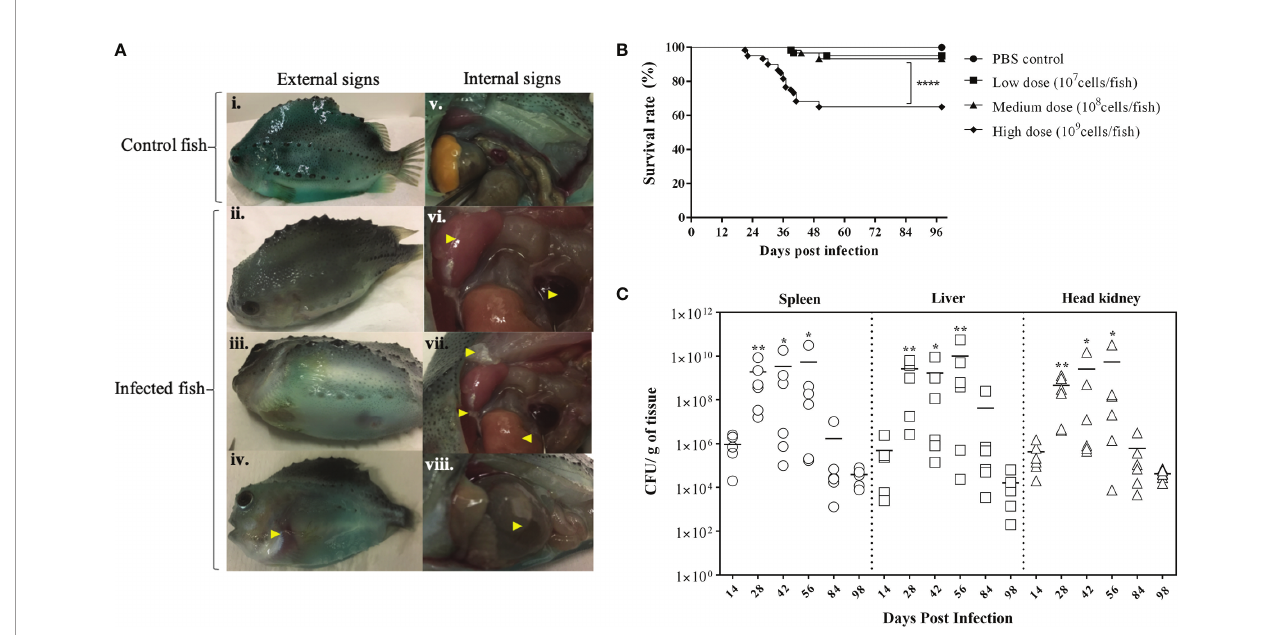
FIGURE 2 | Bacterial Kidney Disease clinical signs, survival rates, and tissue colonization of Renibacterium salmoninarum infected lump fi sh (A) Bacterial Kidney Disease signs and symptoms in lump fi sh detected from 21 to 56 dpi. Pictures were randomly selected to visualize the external and internal signs compared to the control. Speci fi c signs are indicated with yellow arrowheads. The external signs observed were (i) Control lump fi sh; ii. Skin darkening; iii. Abdominal distension due to ascites; iv. Hemorrhages in ventral sites. The internal signs observed were v. Internal organs of control lump fi sh; vi. Enlarged spleen and kidney; vii. Diffuse white membranous layer (pseudo membrane) on internal organs and pale liver; and viii. Accumulation of turbid fl uid inside the abdominal sacs and cavities; (B) Percent survival of lump fi sh exposed to experimental infection with high (1×10 9 cells/ fi sh), medium (1×10 8 cells/ fi sh) or low (1×10 7 cells/ fi sh) doses of R. salmoninarum compared to a PBS control; **** denotes the signi fi cant differences between infected and control groups ( p < 0.001); (C) Renibacterium salmoninarum tissue colonization in lump fi sh. Bacterial loads in spleen, liver and head kidney of lump fi sh ( n = 6) infected with the high dose (1 x 10 9 cells/ fi sh) of R. salmoninarum after 14, 28, 42, 56, 84, and 98 days post infection (dpi). Asterisks (*) represent signi fi cant differences (* p < 0.05, ** p < 0.01) in the bacterial loads between time points (14, 28, 42, 56 and 84 dpi) per organ compared to the bacterial load at 98 dpi, as determined by the non-parametric Kruskal-Wallis